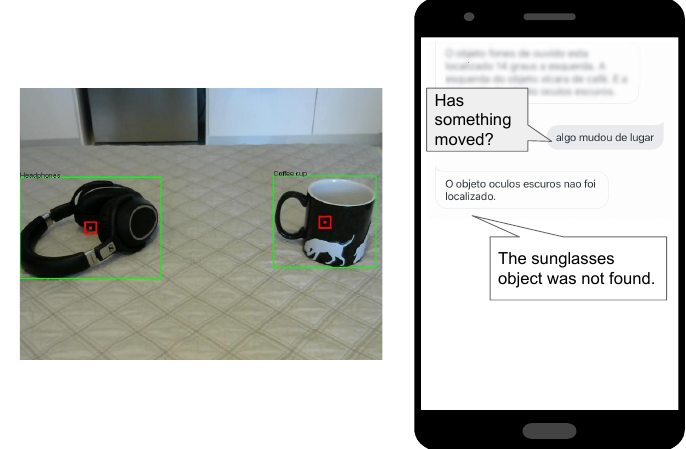
Figure 6. Homer execution—identify when objects are out of the usual places.